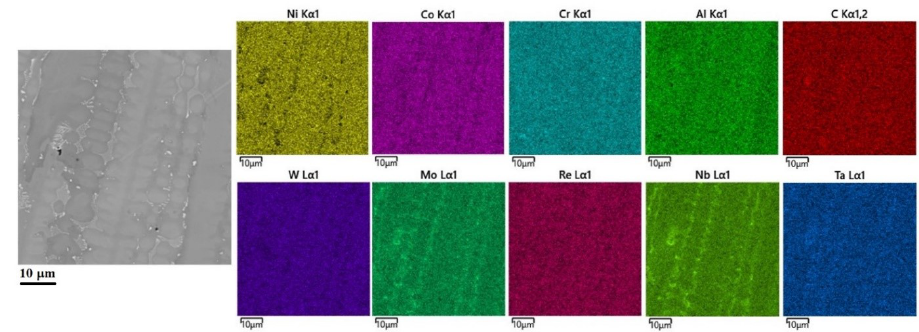
Figure 12. Distribution of elements in modes with high heat input (strategy 1, 600